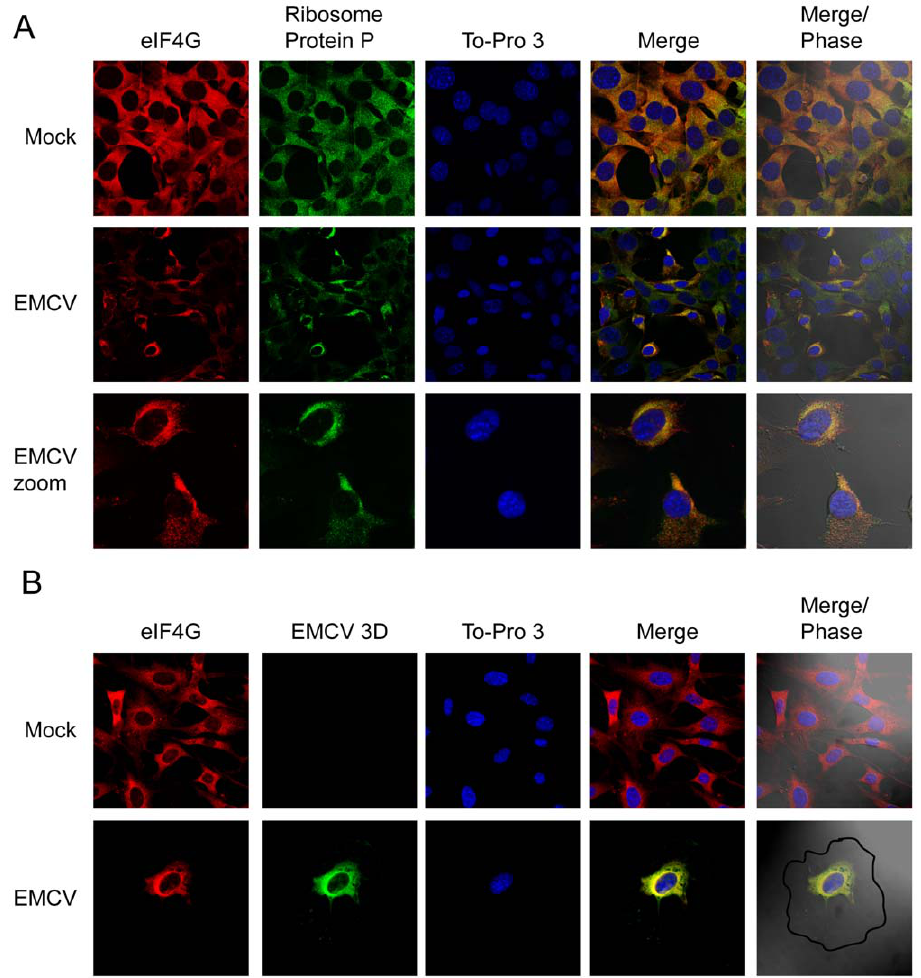
Figure 6. Subcellular localization of eIF4G, ribosomal protein P and EMCV 3D protein in infected cells. Hela cells were seeded on glass coverslips and mock infected or infected with EMCV (10 pfu/cell). At 5 hpi cells were fixed and permeabilized. A) Ribosomal protein P and eIF4G were detected by indirect immunofluorescence in mock- and EMCV-infected cells. ToPro 3 indicates the localization of the nucleus. B) Localization of eIF4G and EMCV 3D proteins. The cell outline was defined by differential interference contrast microscopy (Nomarski).